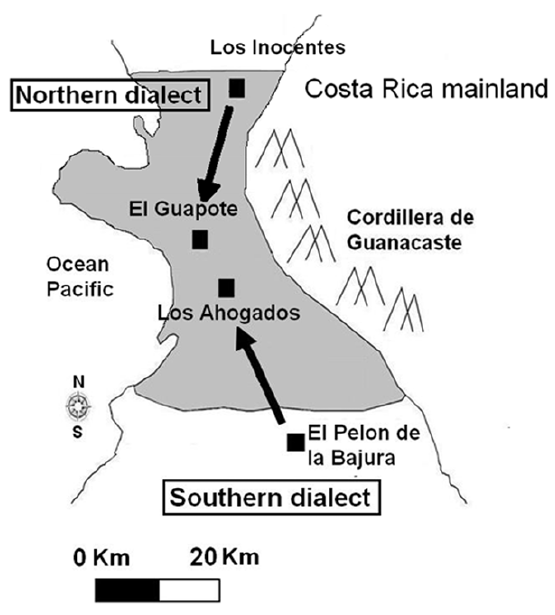
Figure 1. Map of the study area depicting vocal dialects, roosting sites (black solid squares), and movement of translo- cated individuals (arrows).